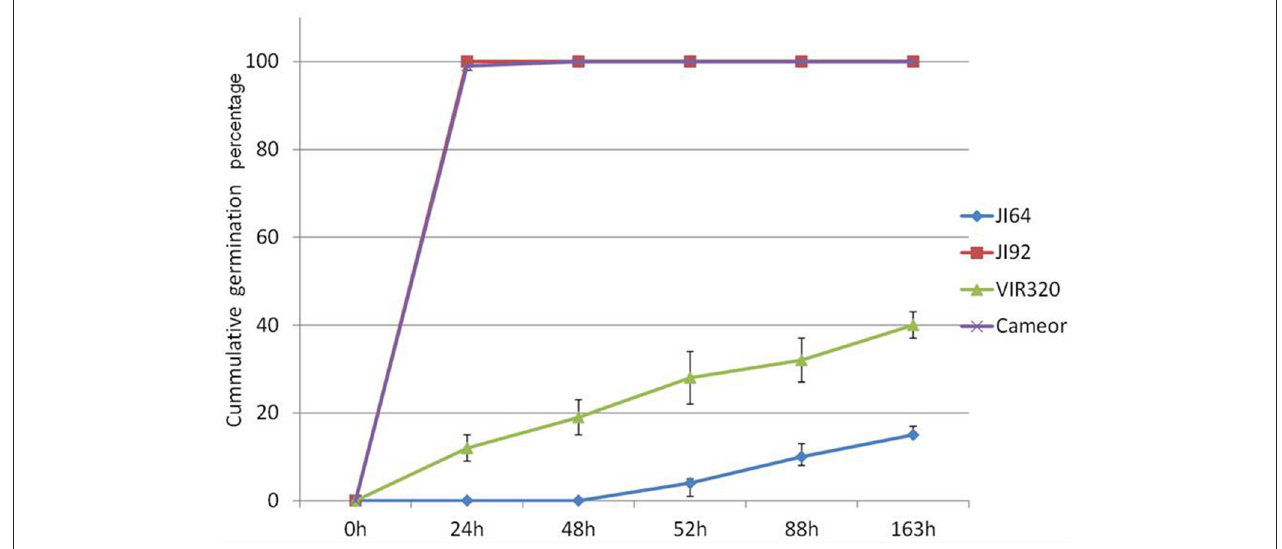
FIGURE 2 | Length of the seed coat palisade cells of selected pea genotypes (Cameor, JI92, JI64, and VIR320). Box plot of median with 25th and 75th percentile, whiskers are 5th and 95th percentile; n = 75; each genotype is different from the other (ANOVA p < 0.001).